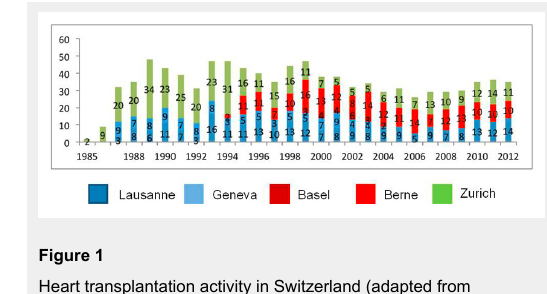
Heart transplantation activity in Switzerland (adapted from Swisstransplant annual